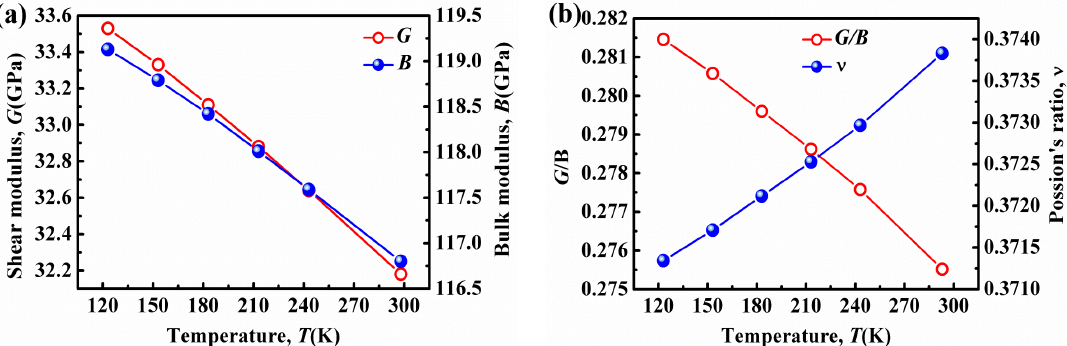
Figure 7. ( a ) Variation of shear modulus, G , and bulk modulus, B , with decreasing temperature; ( b ) variation of Possion’s ratio, ν , and the ratio of G / B with decreasing temperature.